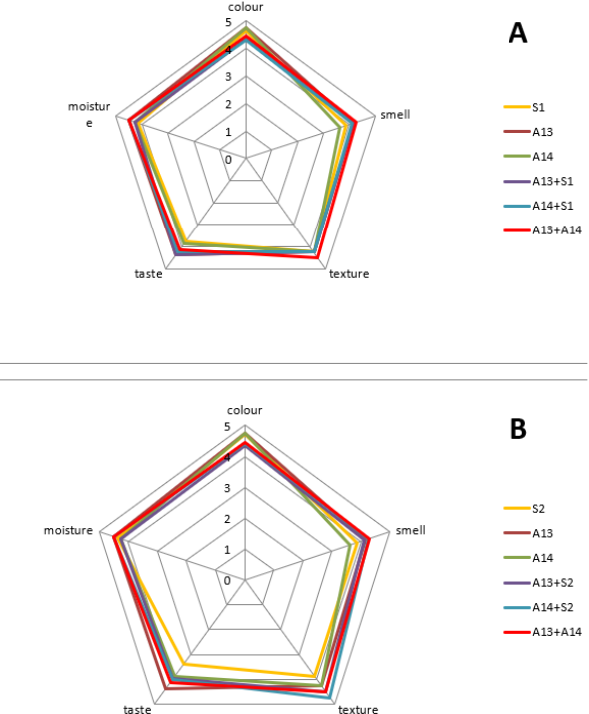
Figure 5. Sensory scores of cottage cheeses according to a 5-point scale; ( A ) cheeses with L. lactis A13 and A14, their blend, commercial starter culture S1, and the blend of A13 and A14 with S1, ( B ) cheeses with L. lactis A13 and A14, their blend, commercial starter culture S2, and the blend of A13 and A14 with